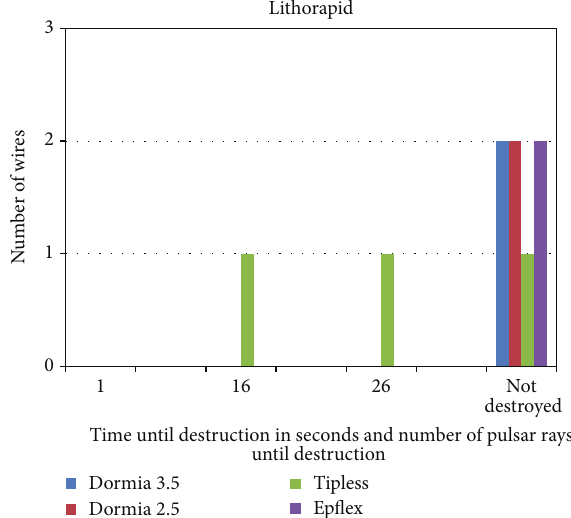
Figure 5: Electrokinetic device (Lithorapid) with destruction of two 1.8 F tipless baskets after 16 or 26 pulses and seconds.